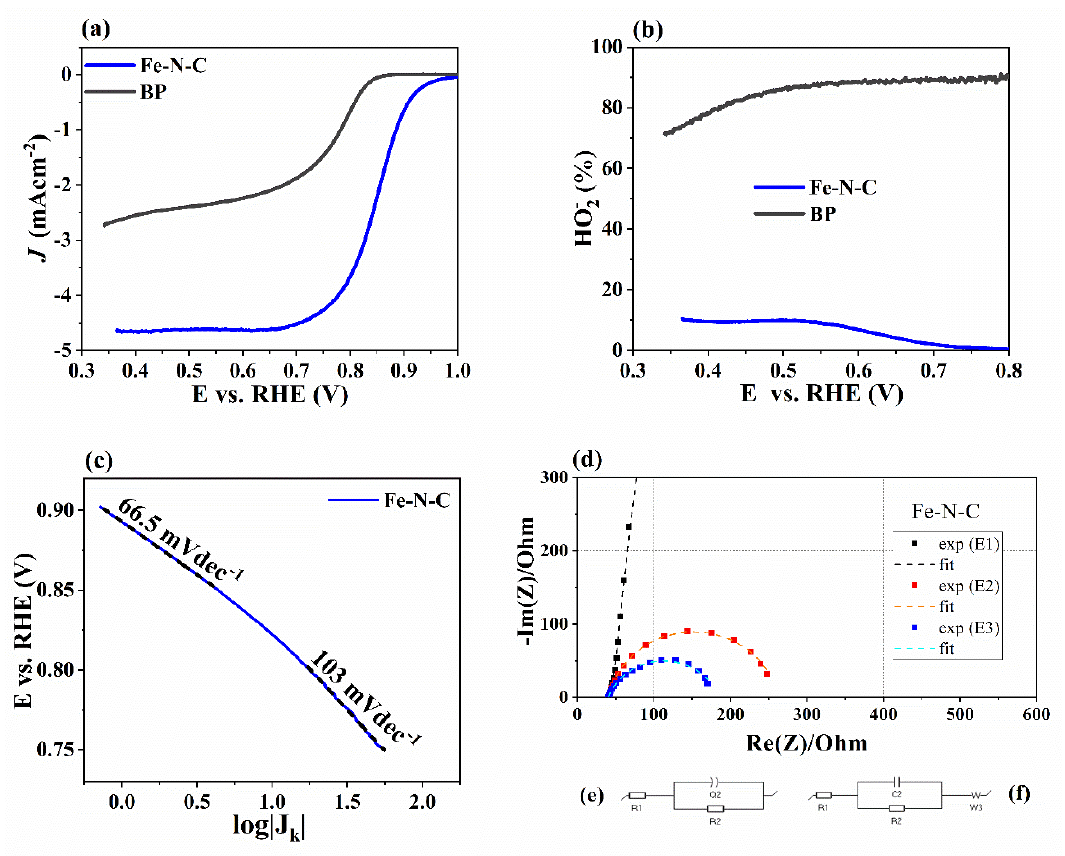
Figure 2. Analysis of ORR activity of Fe-N-C: (a) LSV-RRDE in O 2 -saturated 0.1 M KOH; ( b ) HO 2 − percentage; ( c ) Tafel plot; ( d ) Nyquist plots at 0.95 V(E1), 0.85 V (E2), 0.7 V (E3); ( e , f ) EIS equivalent circuits.